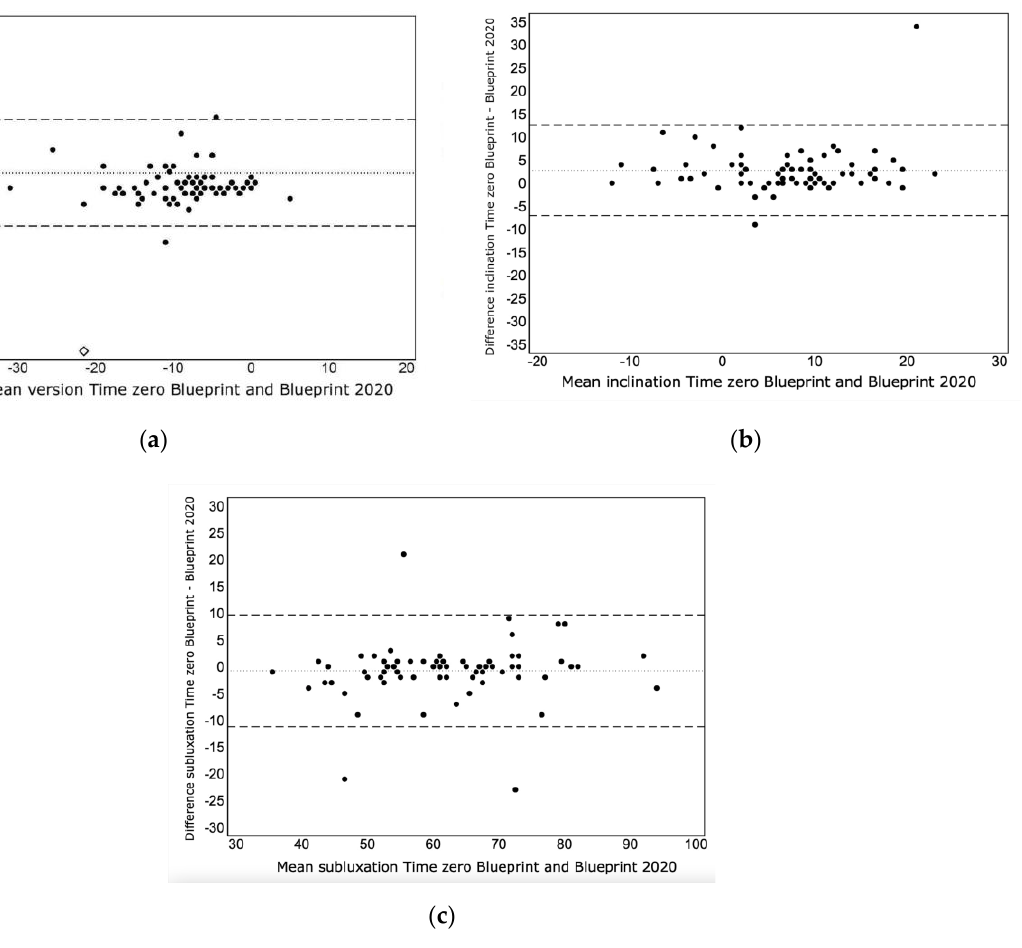
Figure 2. Bland-Altman plots showing variations achieved with software update for glenoid version ( a ), glenoid inclination ( b ) and humeral head subluxation ( c ).